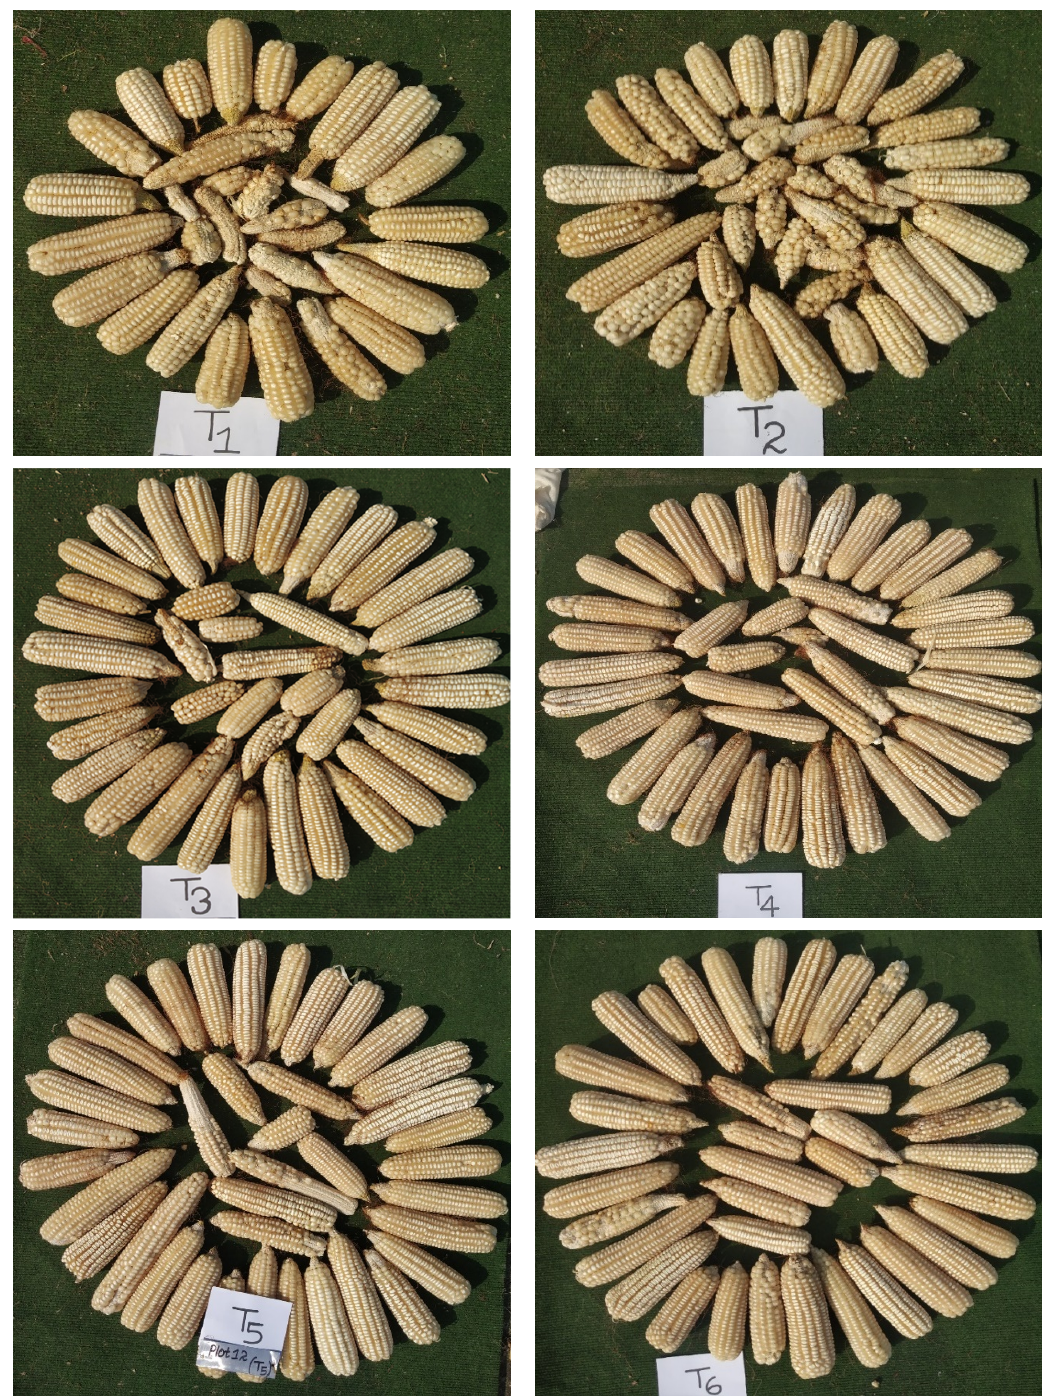
Figure 8. Cob yield in the different treatments as influenced by varying levels of Nitrogen; ( T 1 ) CK—control treatment, ( T 2 ) N0—0 kg ha −1 N, ( T 3 ) N60—60 kg ha −1 N, ( T 4 ) N120—120 kg ha −1 N, ( T 5 ) N180—180 kg ha −1 N, ( T 6 ) N240—240 kg ha −1 ment, ( T 2 ) N0—0 kg ha − 1 N, ( T 3 ) N60—60 kg ha − 1 N, ( T 4 ) N120—120 kg ha − 1 N, ( T 5 ) N180—180 kg ha − 1 N, N. ( T 6 ) N240—240 kg ha − 1